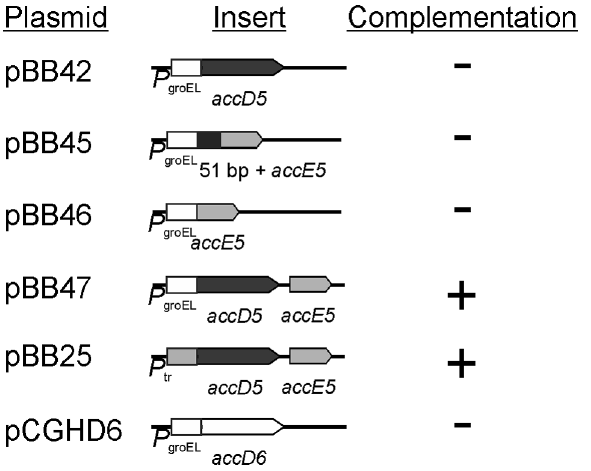
Figure 2. Complementation of the accD5-accE5 conditional mutant. Schematic representation of the pMP395 derived construc- tions used in the complementation studies.